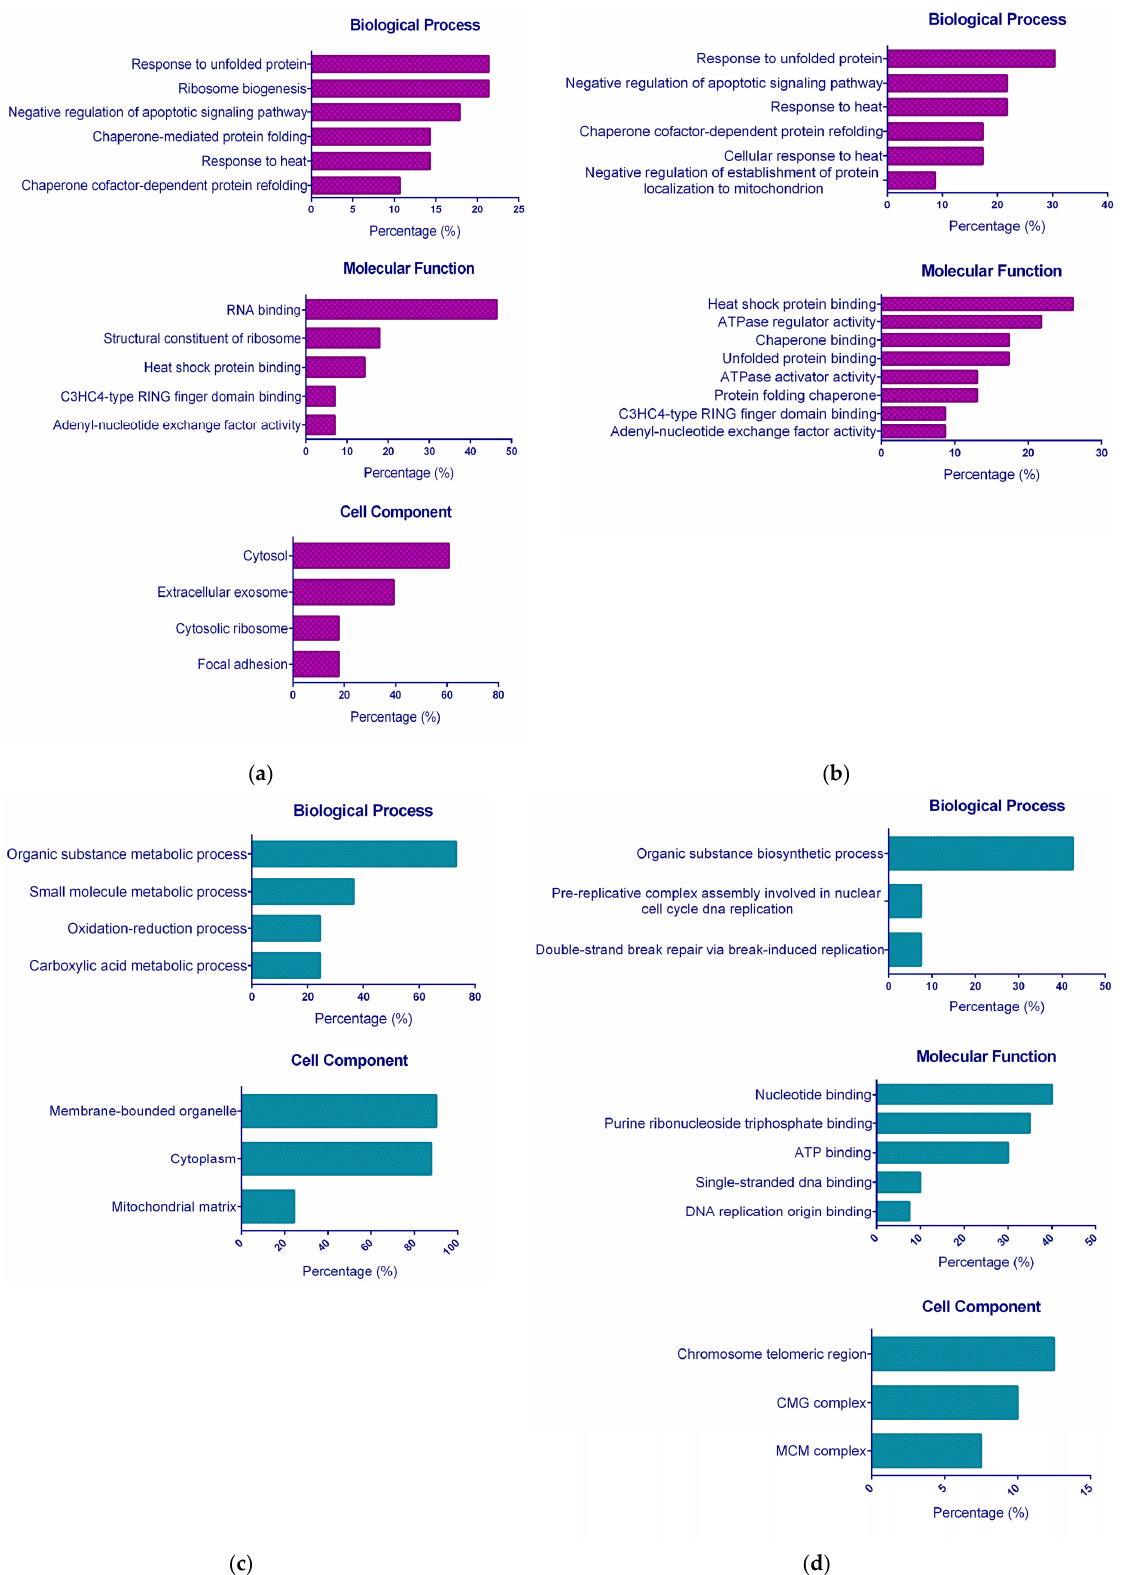
Figure 3. GO enrichment analysis of ( a , b ) up-regulated proteins after treatment with ( a ) CuHL1 and ( b ) CuHL2; ( c , d ) down-regulated proteins after treatment with ( c ) CuHL1 and ( d ) CuHL2. The percentage (%) of representation of each category was determined as a percentage of the total differentially expressed protein.